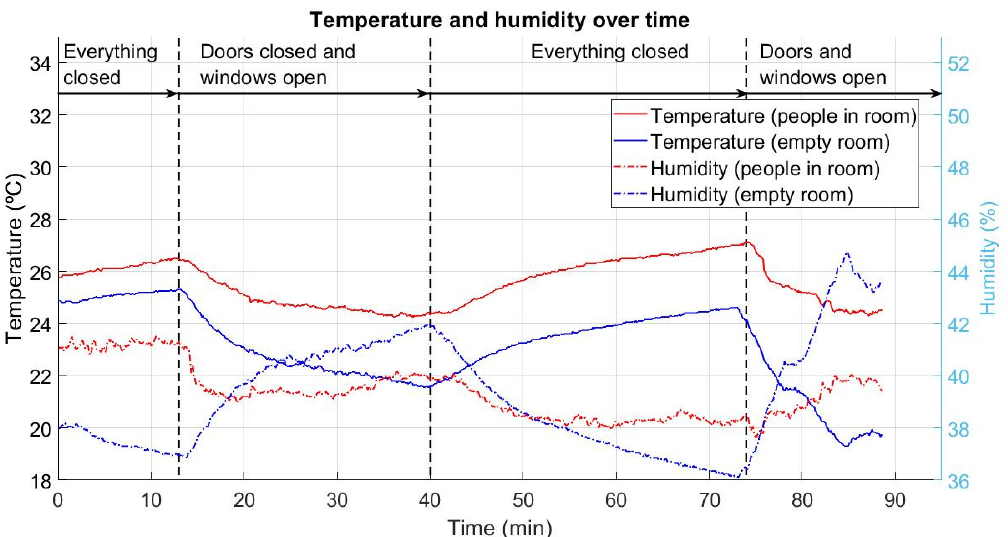
Figure 4. Temperature (°C, continuous line) and relative humidity (%, discontinuous line). Red lines correspond to the populated room (15 people) scenario. Blue lines correspond to the empty room scenario. First time stretch: closed room; second time stretch: windows open; third time stretch: closed room; fourth closed room: windows and doors open.